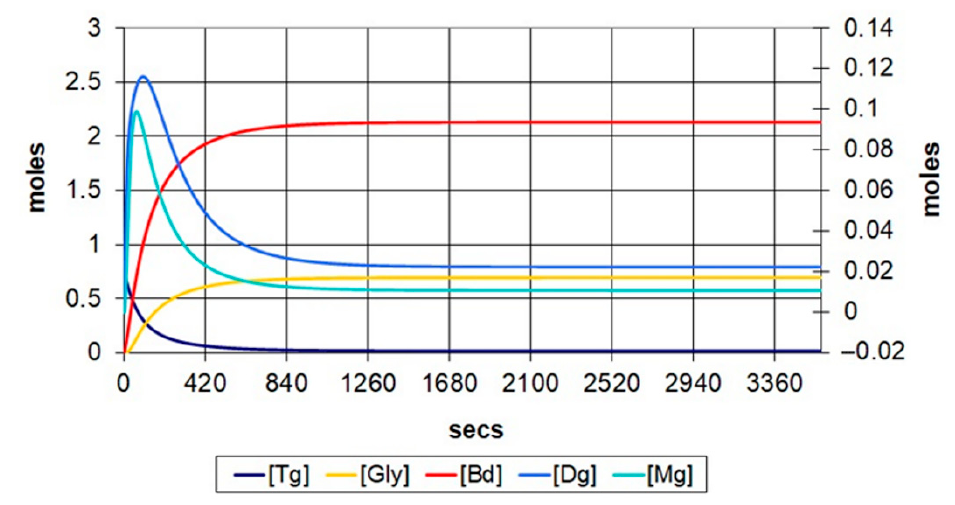
Figure 6. Transesterification reaction at 60 ◦ C and 9:1 molar